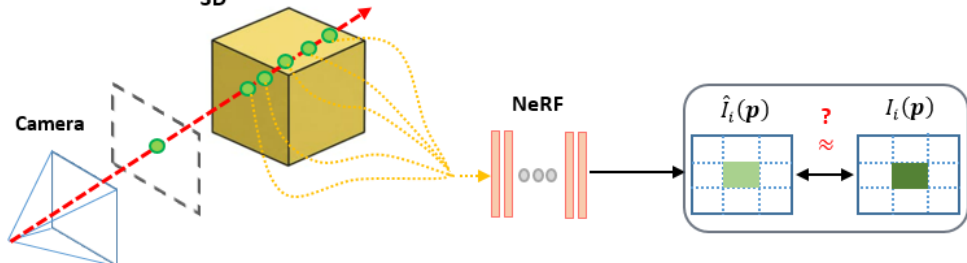
Figure 3. Summary of the NeRF-- framework. A NeRF model and the camera parameters of the input images are simultaneously optimized by minimizing the photometric reconstruction error (cid:107) I − ˆ I (cid:107) 2 ( E = ∑ N ) between the input and the reconstructed images, and a pixel, p is rendered once i i i = 1 2